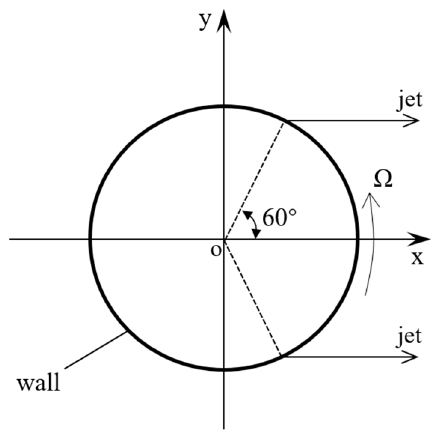
Figure 5. Geometric model of parallel jets.